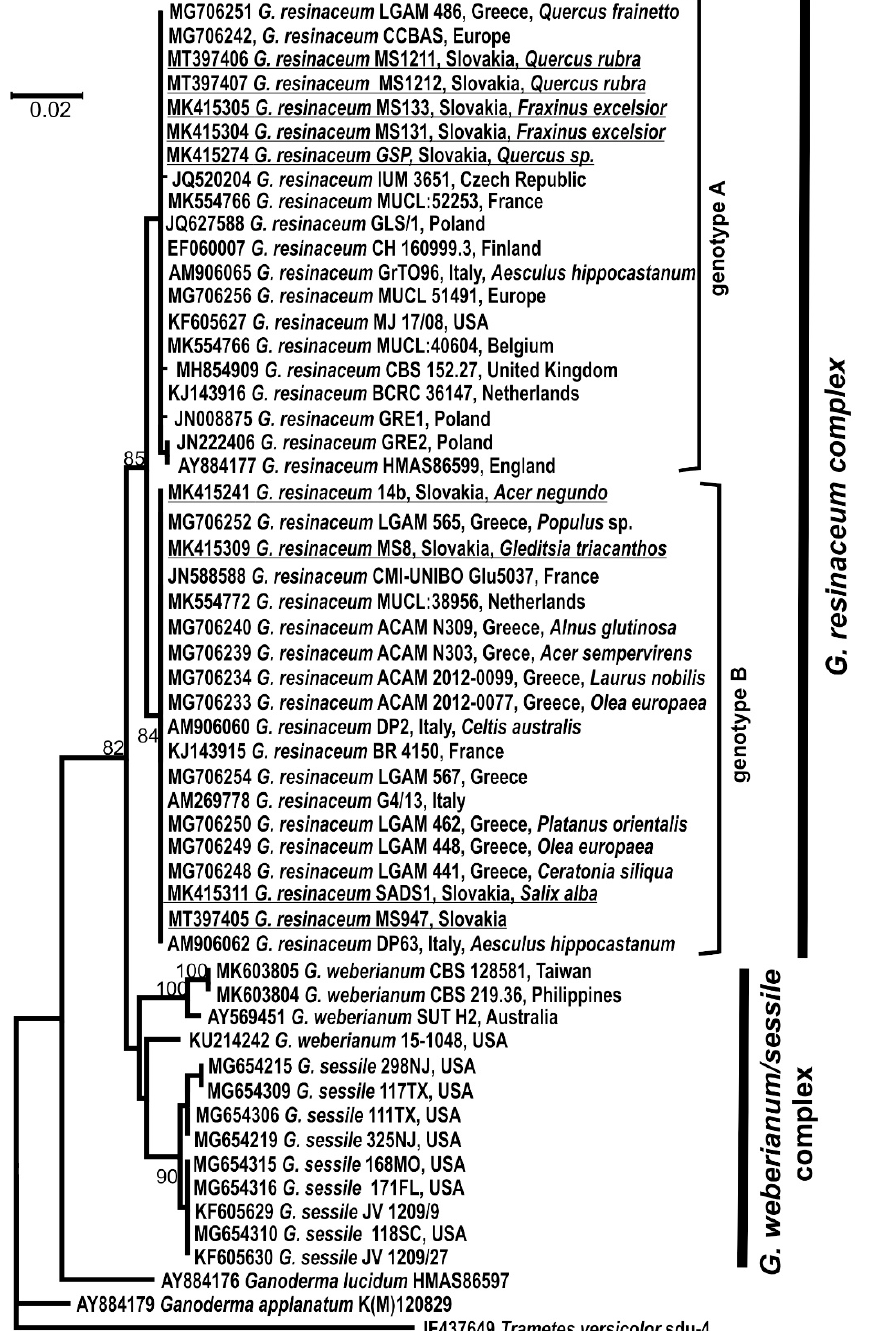
Figure 2. Genetic diversity between Ganoderma resinaceum genotypes and related Ganoderma species documented by internal transcribed spacer (ITS) sequence analysis. Maximum parsimony phylogenetic tree documenting phylogenetic relatedness of Ganoderma resinaceum specimens from Slovakia based on internal transcribed spacer sequences comparison. The sequences obtained through this study are underlined. Numbers at nodes are bootstrap values after 1000 repetitions (only values over 80 are shown). ITS sequence of Trametes versicolor (GenBank accession number JF437649) was used as an outgroup. The geographical origin and host plant of specimens are shown (if available). The bar indicates the number of nucleotide changes over the whole sequence.